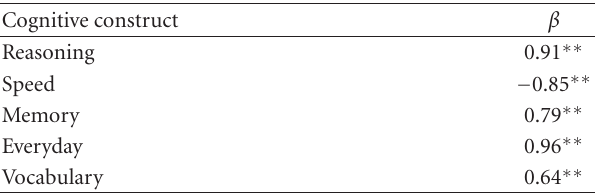
Table 4: Standardized coe ffi cients ( β ) for loadings of